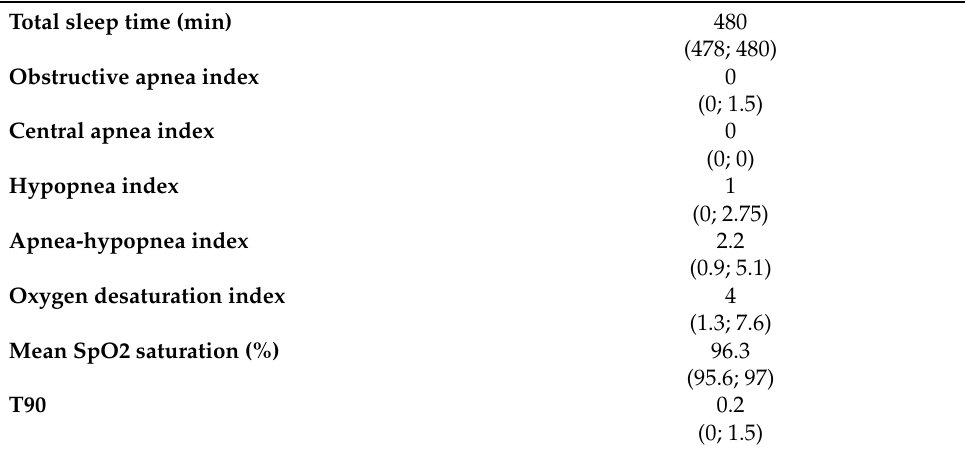
Table 4. Overnight polygraphy data from 48 Down syndrome